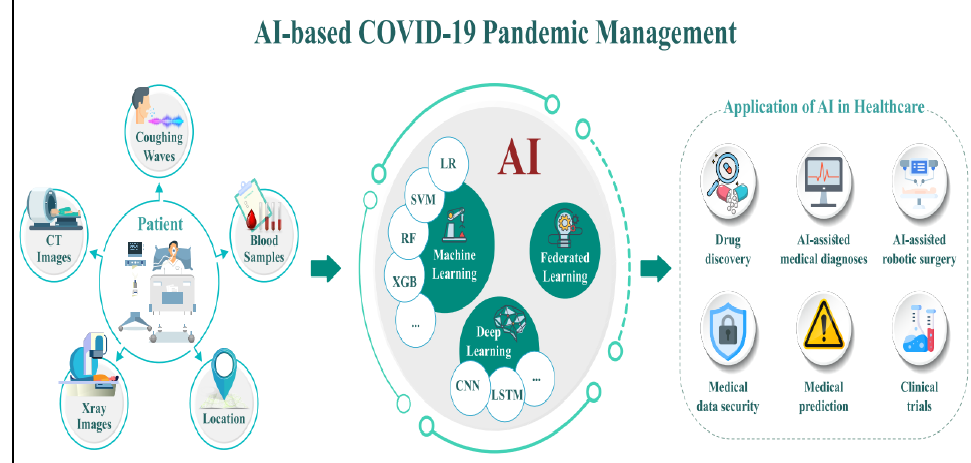
Figure 1. AI-based COVID-19 Management Architecture.